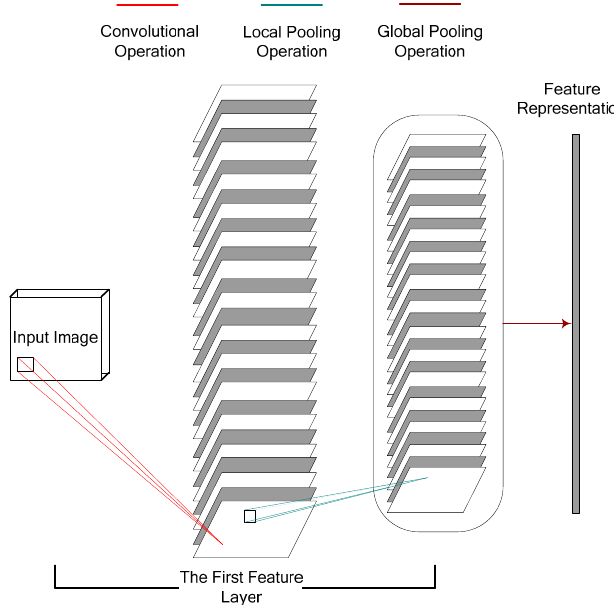
Figure 1. Unsupervised convolutional feature extraction network with one feature layer.